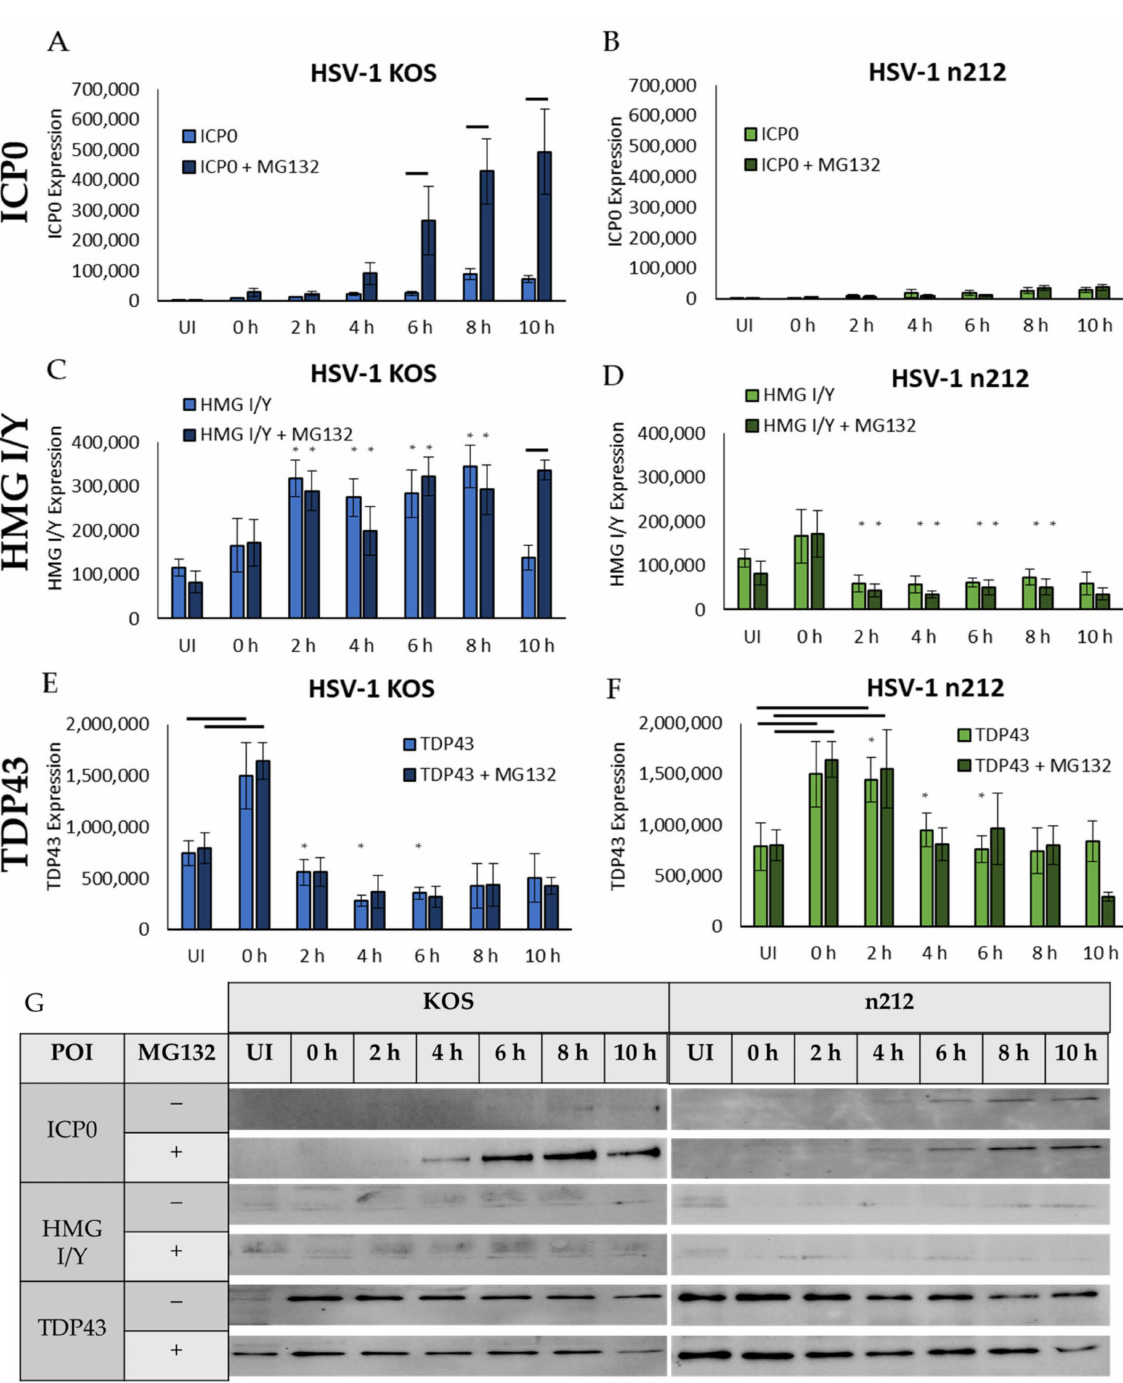
Figure 5. Protein expression of ICP0 ( A , B ), HMG I/Y ( C , D ), and TDP43 ( E , F ) during 10 h of HSV-1 KOS and HSV-1 n 212 productive infection in primary adult DRG neuronal cultures, with or without MG132 to inhibit proteasomal degradation. Neurons were assessed every 2 h by Western blot ( n = 3), analyzed by densitometry, and normalized to total protein visualized with TCE. Representative Western blots are shown ( G ). Error bars = SD. Horizontal bars indicate statistical significance between MG132 treated and untreated ( A , C ) or between 0 h and 2 h and UI ( E , F ) ( p < 0.05). Asterisks indicate statistical significance between KOS- and n 212-infected neurons ( p <